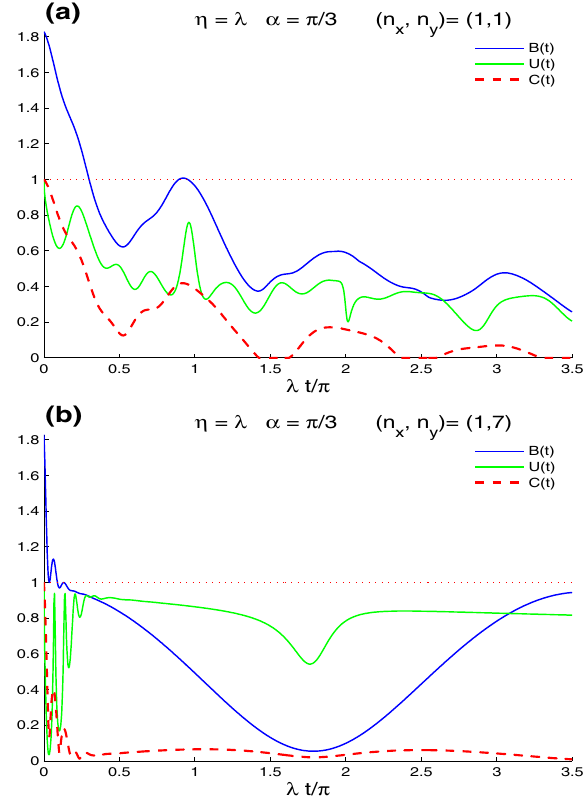
Figure 6. Dynamics of the non-local correlations of Figs. 4b and the 5a but in the presence of the decoherence 0.25 10 2 (cid:31) γ = ×